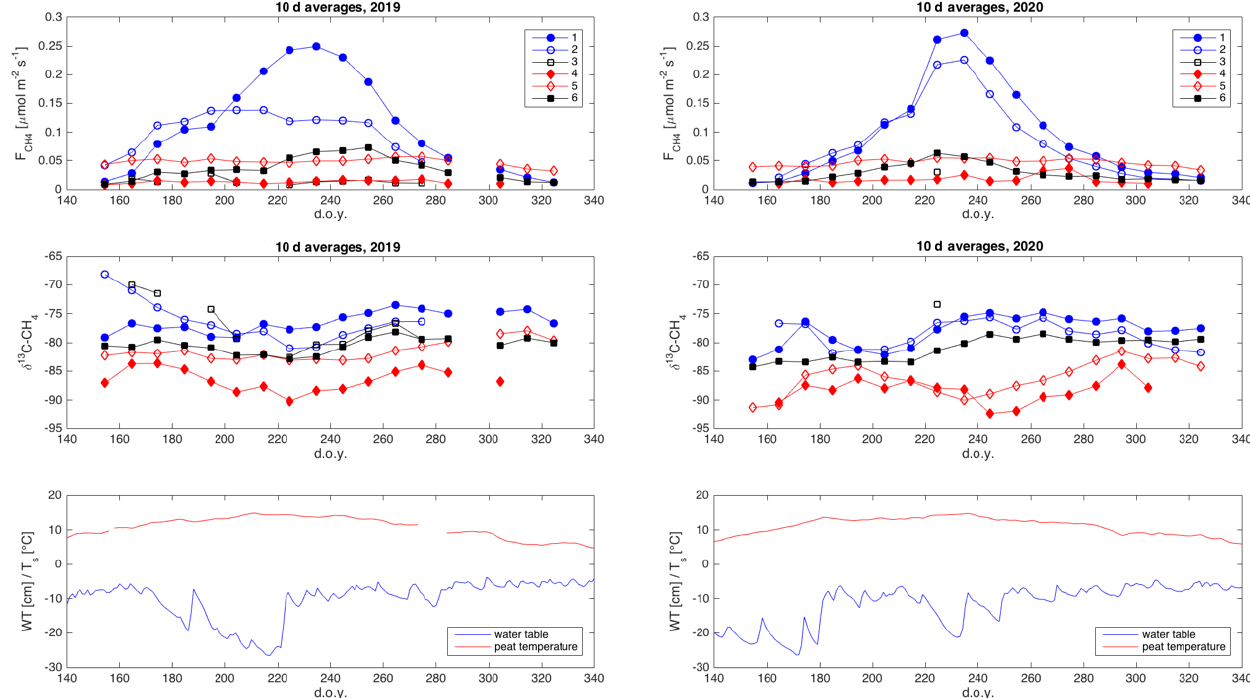
Figure 7. Time series of 10d averages of methane emission and δ 13 C-CH 4 measured from the six chambers and peat temperature at 30cm depth and the water table position in 2019 and